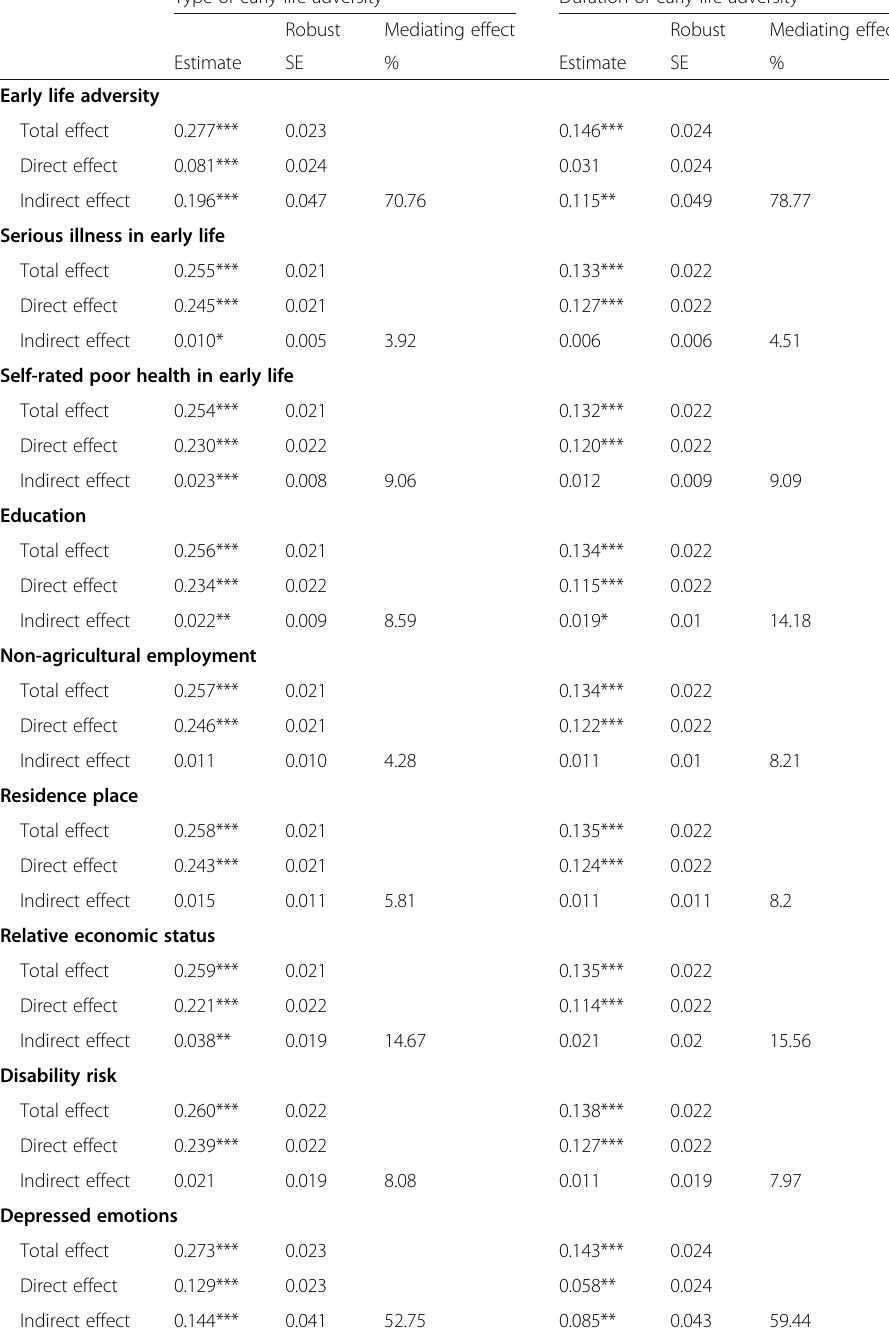
Table 5 Decomposition of the channel effect of early life adversity on health ( N =